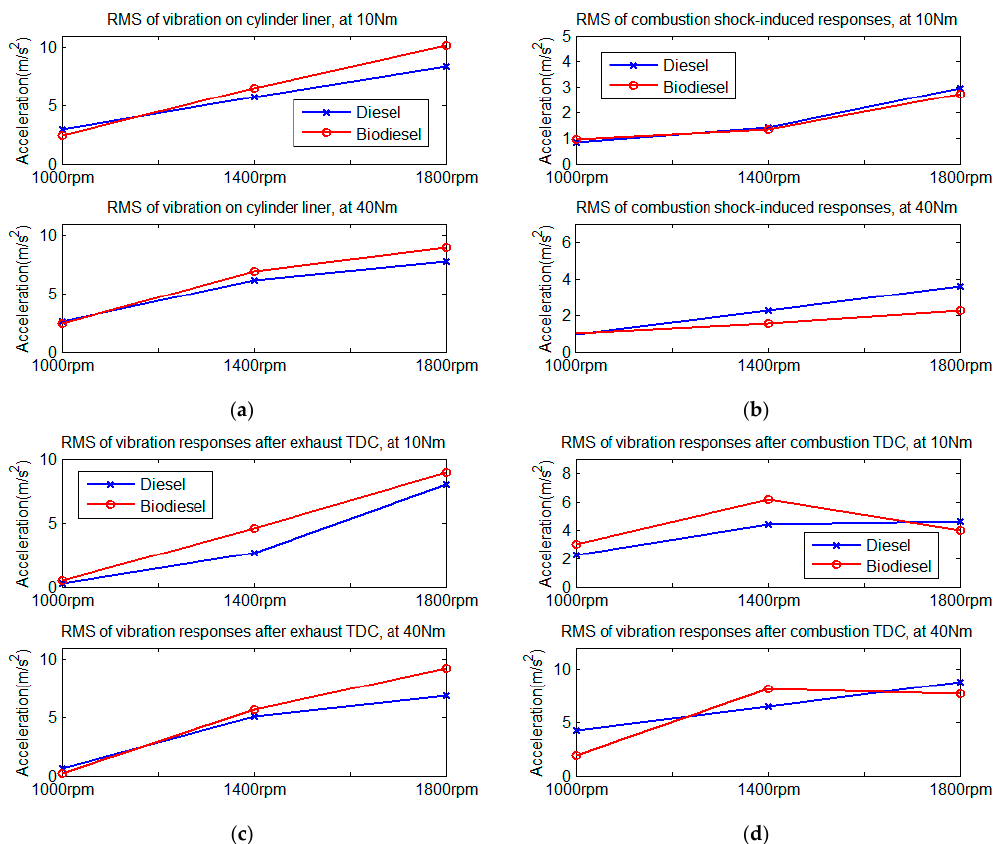
Figure 23. Comparison of characteristic parameters between different fuels; ( a ) Overall RMSs of liner vibrations; ( b ) RMSs of localised responses to combustion shocks; ( c ) RMSs of local responses after exhaust TDC; ( d ) RMSs of local responses after combustion TDC.